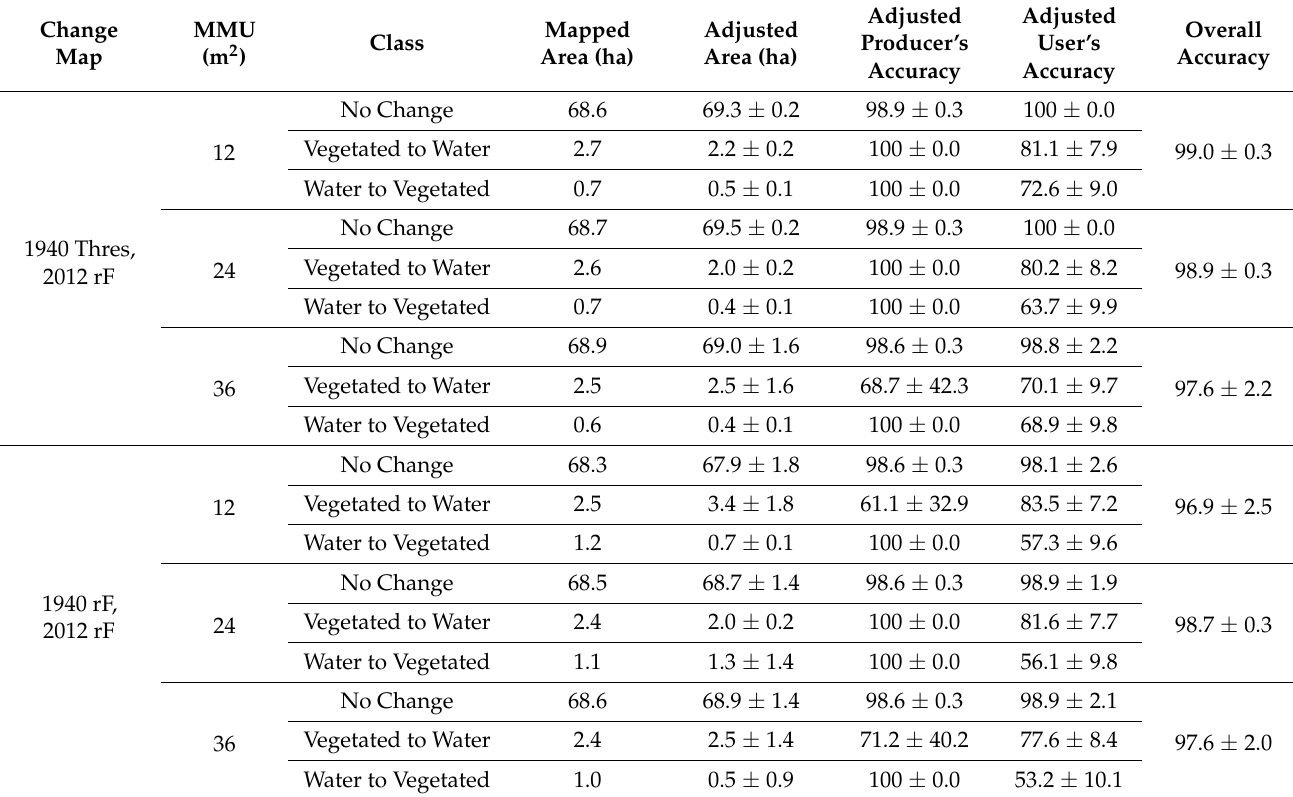
Table 3. Area-adjusted accuracy estimates for change maps (percent ± 95% confidence interval) including total mapped area. Thres = threshold classifications; rF = random forest classification.